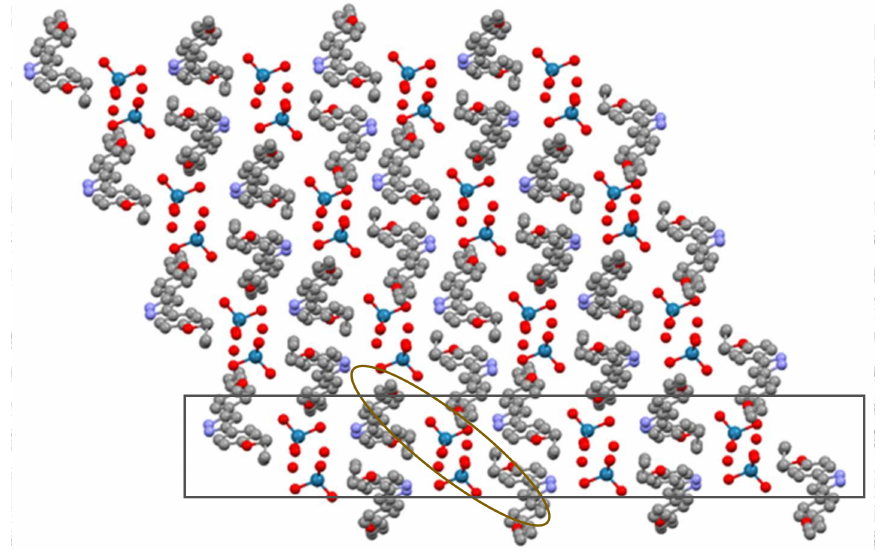
Figure 5. Packing in the ac plane (ellipse: double column, rectangle: